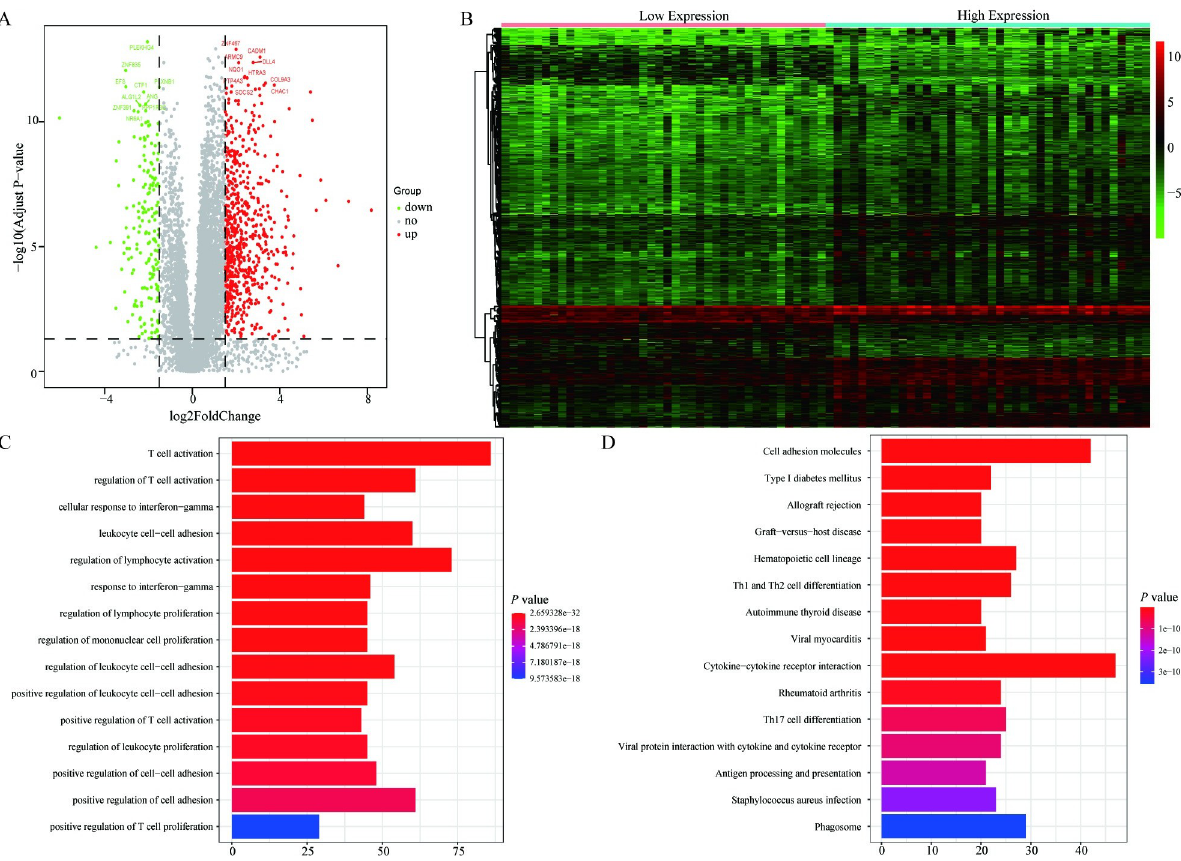
Fig 6. Analysis of differential genes between CARD11 high and low expression groups. ( A, B ) Heat maps and volcano plots showed the expression of DEGs between CARD11 high and low expression group. ( C, D ) GO and KEGG analysis showed that these DEGs were involved in T cell activation pathway and cell adhesion molecule-related signal pathway.